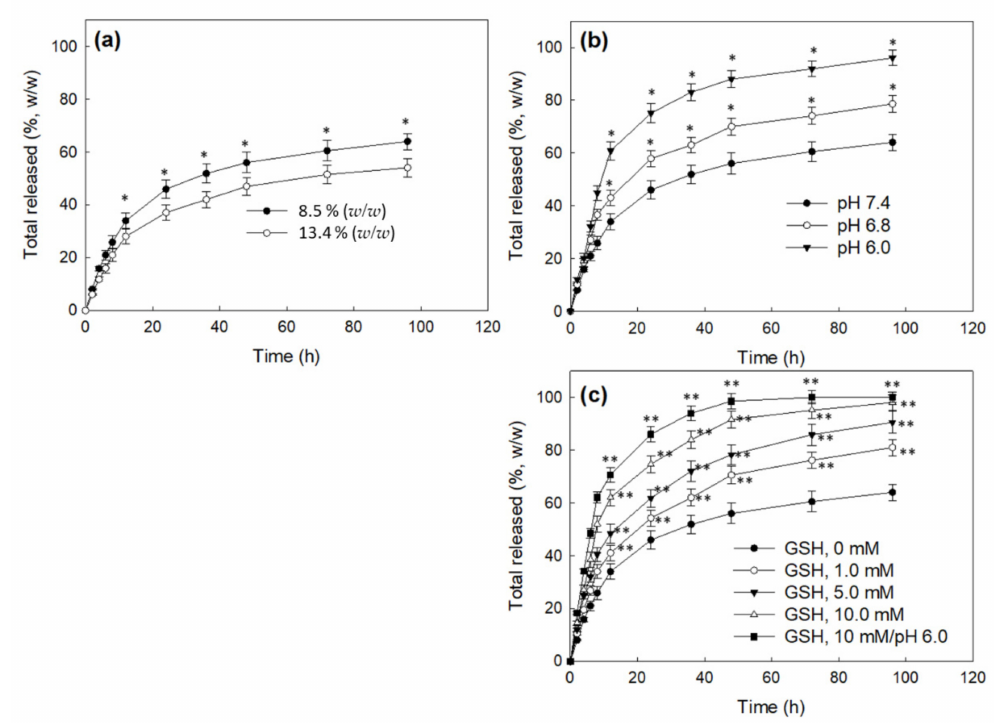
Figure 5. DOX release from ChitoHISss nanoparticles. ( a ) The effect of drug contents; ( b ) the effect of the pH of the nanoparticle solution; ( c ) the effect of GSH addition and acidic pH. All results were triplicated and are expressed as average ± S.D. Statistical analysis: * indicates comparison between 8.5% ( w / w ) and 13.4% ( w / w ); * also indicates comparison between pH 7.4 and pH 6.8 or pH 6.0.; ** indicates comparison between GSH (0 mM) and GSH 1.0 mM, 5 mM, 10 mM, or